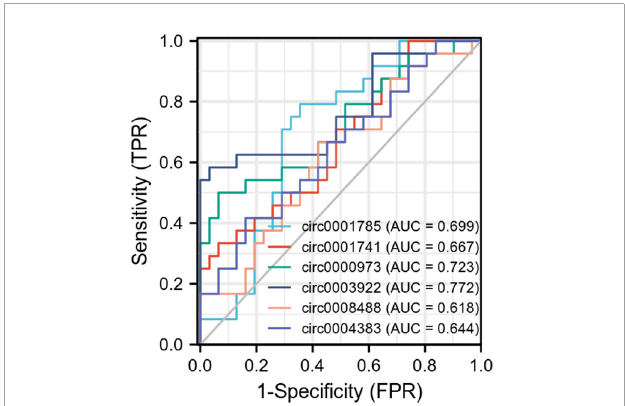
FIGURE6 Receiver operator characteristic (ROC) curve of circRNA for the diagnosis of coronary heart disease (CHD). As shown in the figure, each point on the curve corresponds to the FPR and TPR at different thresholds. TPRate refers to the proportion of all samples of true category 1 that are predicted to be in category 1. FPRate refers to the percentage of all samples with true category 0 that are predicted to be in category 1. AUC refers to the random selection of a positive sample and a negative sample from a given category. The classifier predicted that the probability of a positive sample being positive was P1 and that of a negative sample being positive was P2. AUC is the probability that P1 >